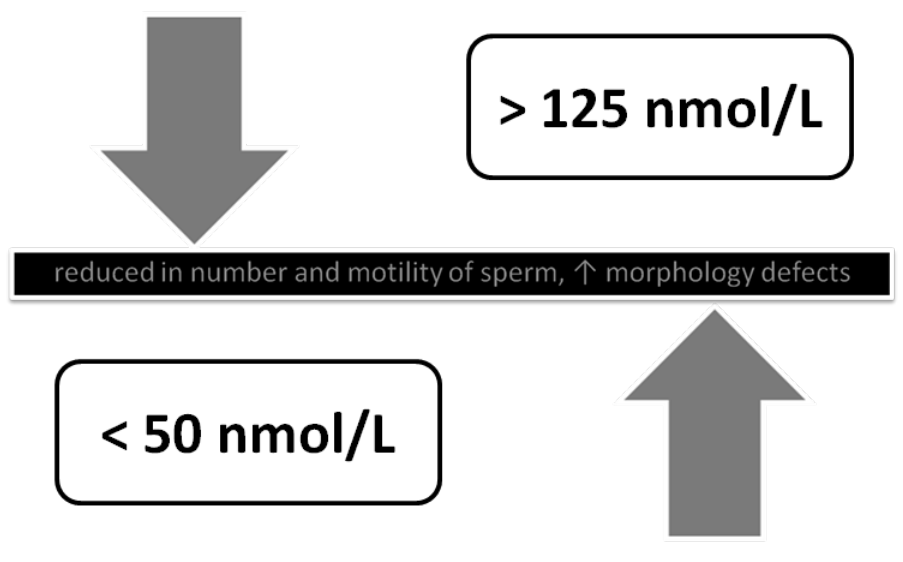
Figure 3. The influence of vitamin D on the activity and the morphology of sperm (after: Grzechocinska B, Dabrowski FA, Cyganek A, Wielgos M. The role of vitamin D in impaired fertility treatment